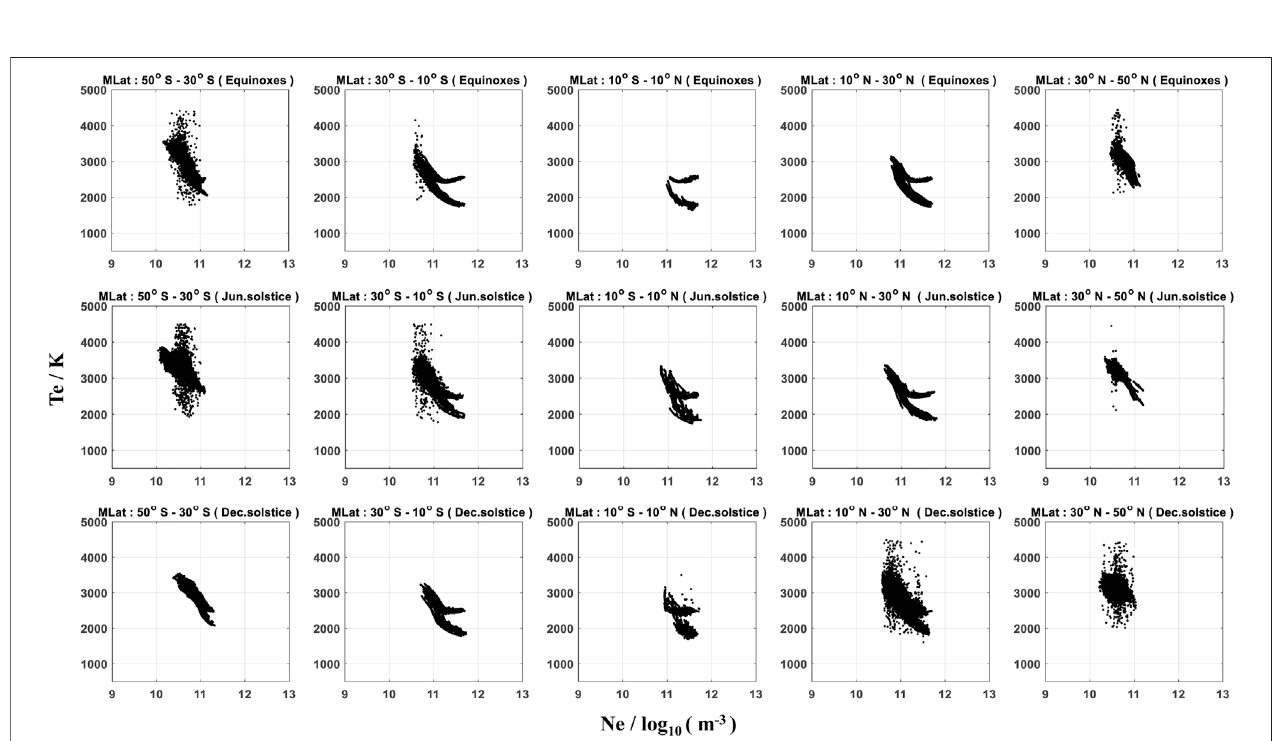
FIGURE 6 | As same as Figure 5 , but for Swarm B